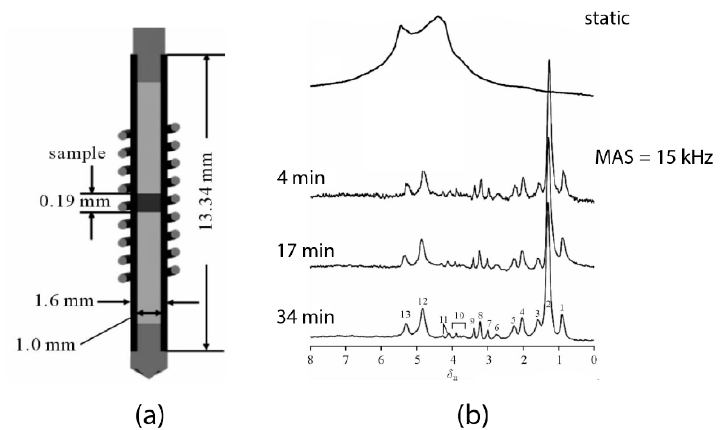
Figure 1. ( a ) The sample-configuration in a 1.6-mm rotor with Kel-F inserts [23]. ( b ) Spectral comparison 1 H magic-angle spinning (MAS) NMR of a mouse muscular tissue at 21.1 T (900 MHz for